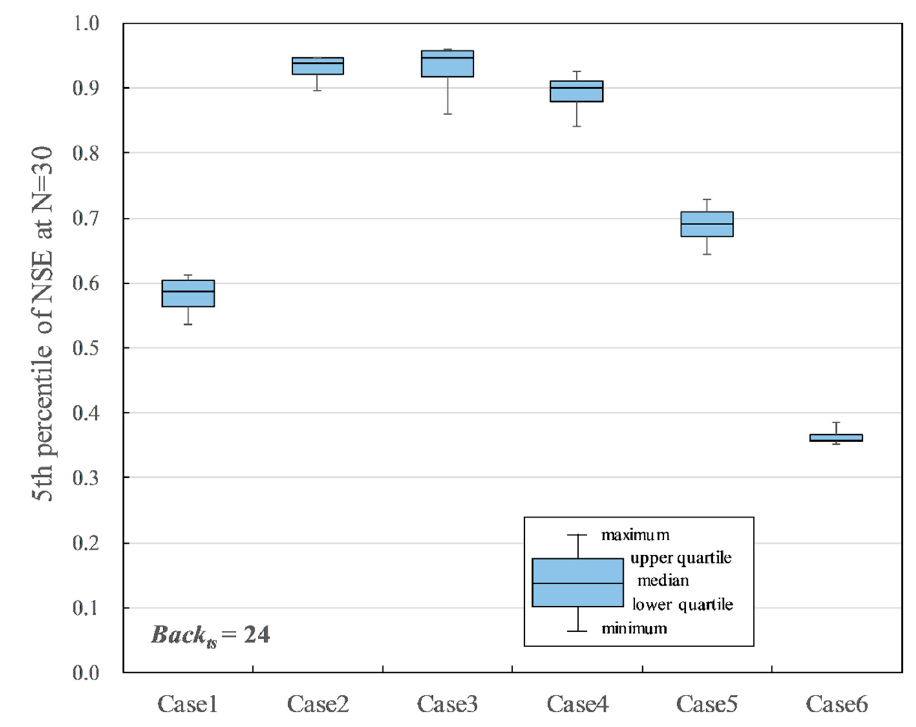
Figure 9. Summarized training results for Case 1 to Case 6 when Back ts = 24, Drp = 0, Drp r = 0.